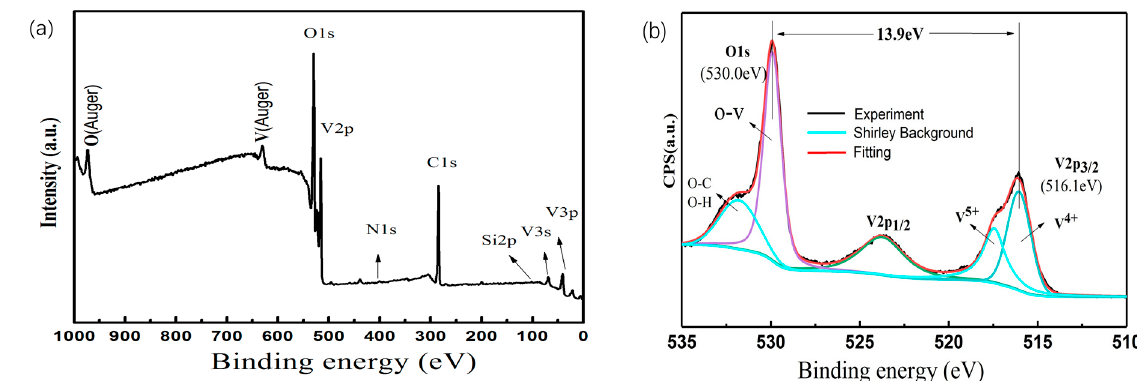
Figure 4. ( a ) XPS measure spectra with binding energy in the range of 0–1000 eV for sample S 2-2 . ( b ) The enhanced high-resolution spectra with binding energy in the range of 510–535 eV and the fitting results for sample S 2-2 .